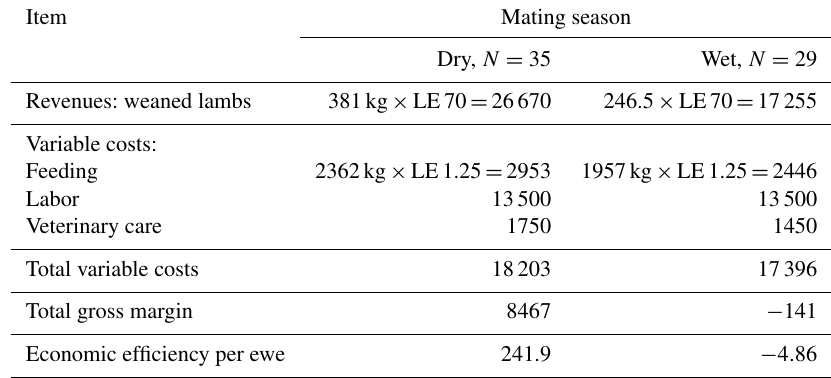
Table 7. Breakdown of revenues and variable costs of the two simulated flocks.